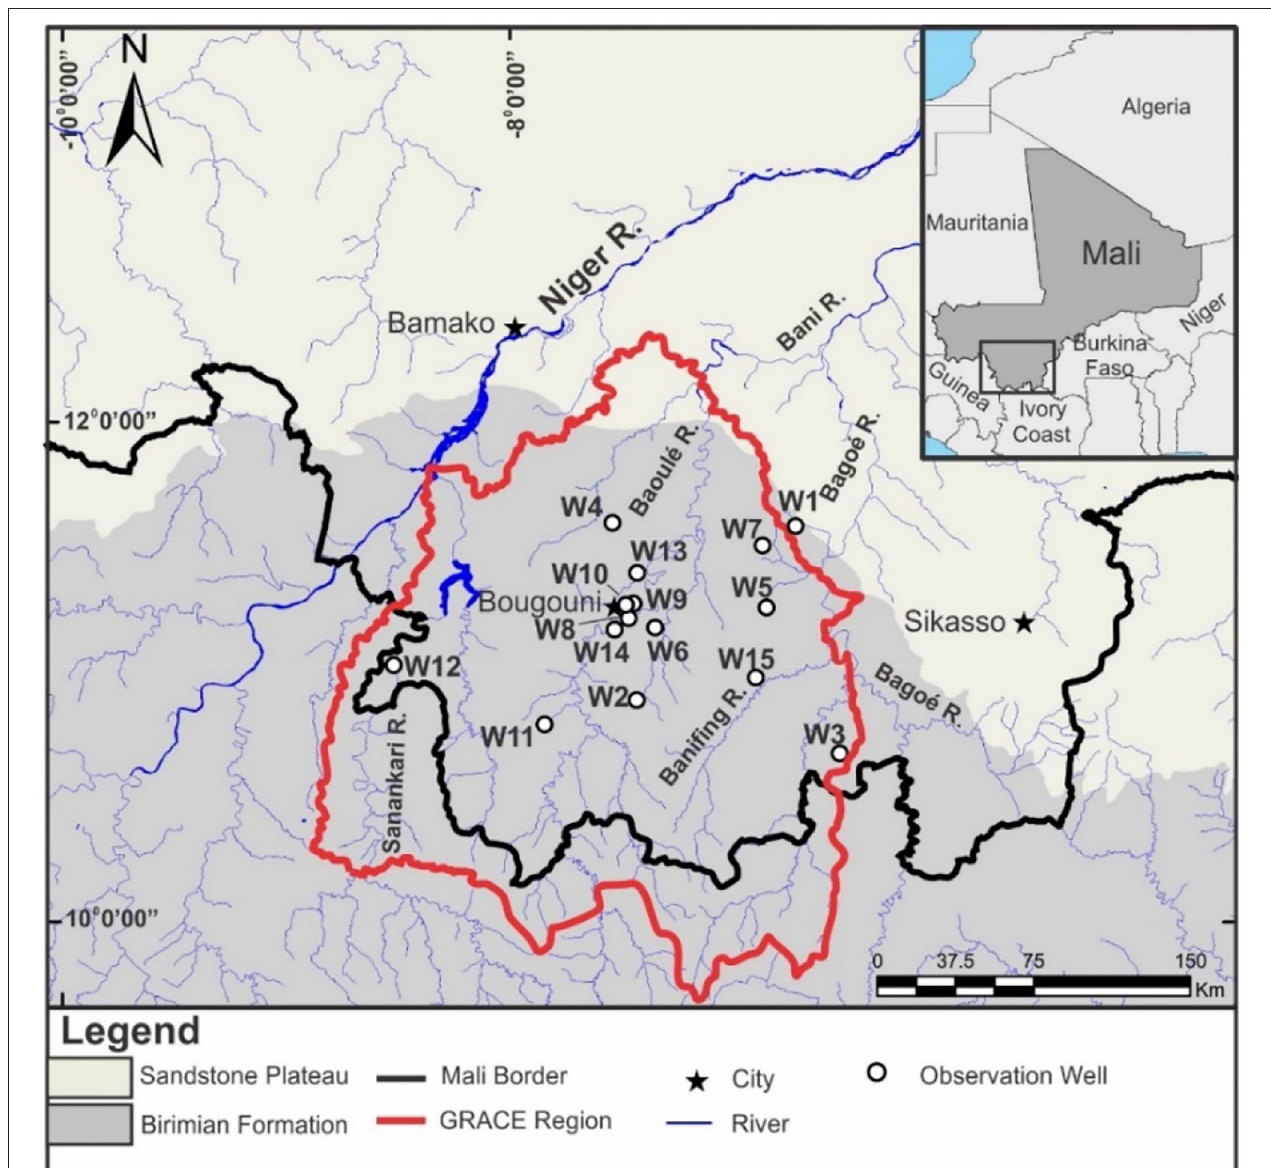
FIGURE 1 | The study region in southern Mali showing the GRACE region (delineated with a thick red line), the observation wells (see Supplementary Table 1 for well details), and the major geological units including the Birimian Precambrian crystalline bedrock (south in gray) and the “Sandstone Plateau” Infra-Cambrian A Formation (north in beige). Insert map shows Mali in northwestern